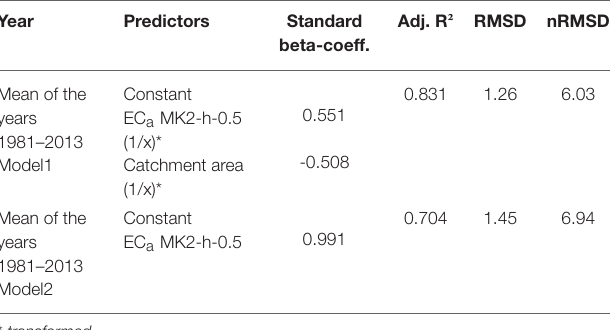
TABLE 4 | Simulation of the yield of the control plots (means of the years 1981–2013) with REG (above: Model 1 predictors EC a , relief, coordinate, below: Model 2 predictors EC a ), (further information see Supplementary Table 1 ).